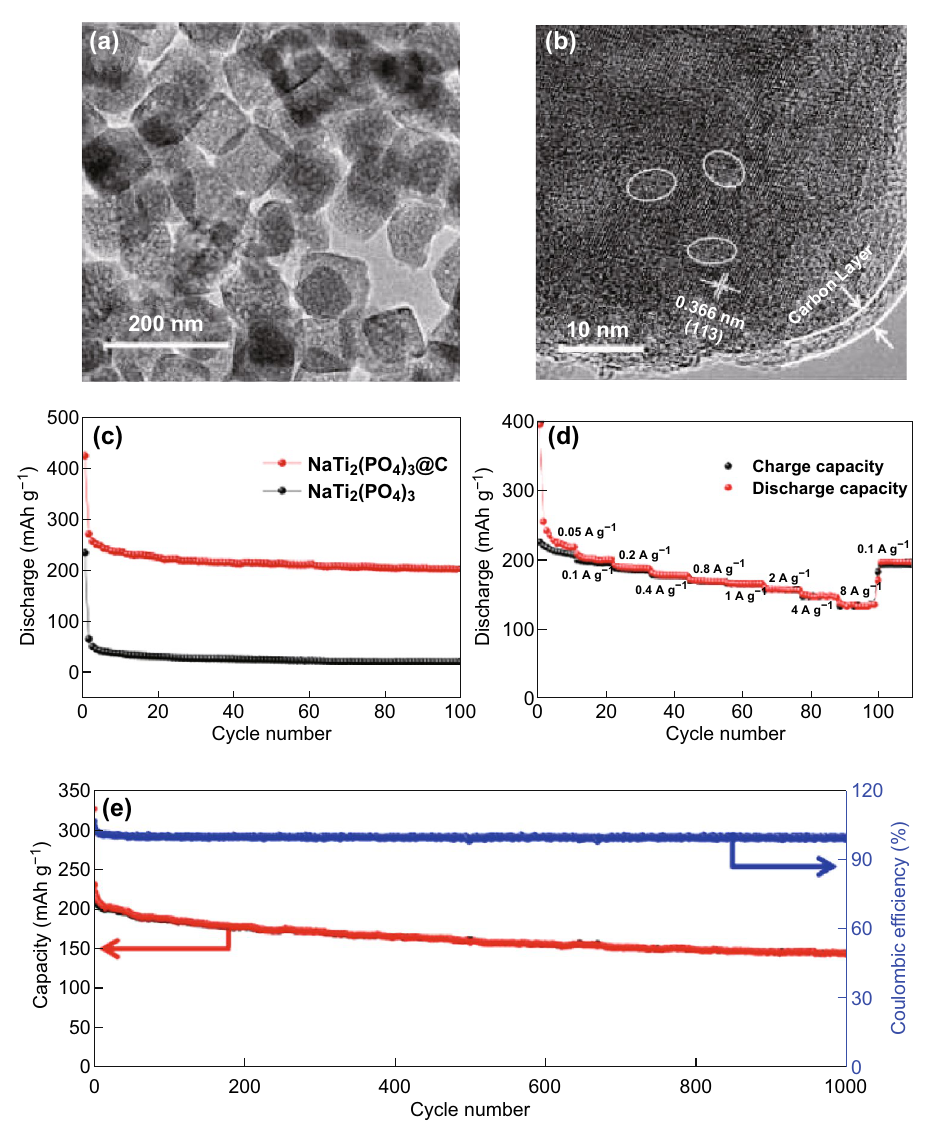
Fig. 3 a , b TEM images of NaTi 2 (PO 4 ) 3 @C. c Cycling performances of NaTi 2 (PO 4 ) 3 @C and NaTi 2 (PO 4 ) 3 at 100 mA g −1 . d Rate capabilities of NaTi 2 (PO 4 ) 3 @C and e cycling performance of NaTi 2 (PO 4 ) 3 @C at the higher current density of 1 A g −1 [81]. Copyright 2017, Elsevier